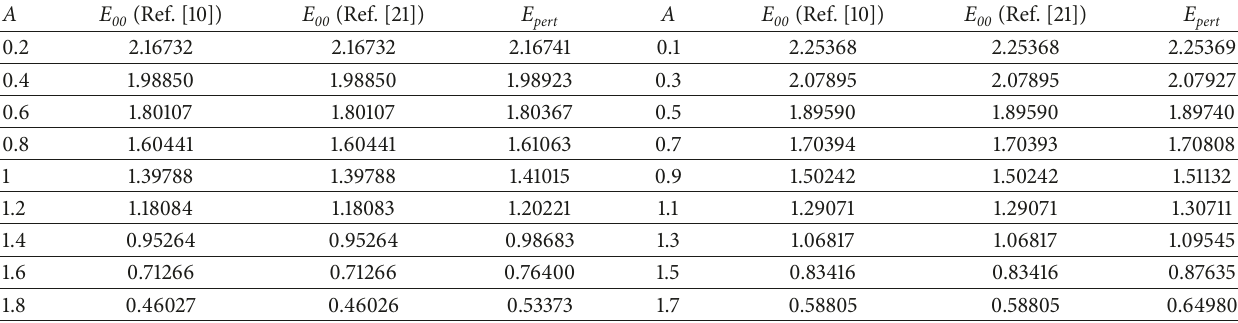
Table 5: Comparisons of energy eigenvalues (in GeV) obtained by using the perturbation expansion formula in (26) ( 𝐸 𝑝𝑒𝑟𝑡 ) with the ones of s-wave heavy quarkonium from [10, 21]. The potential parameter 𝐵 is taken as 𝐵 = 1 GeV, while the reduced mass is 𝜇 = 1/2 GeV in this case. The eigenvalues of [10, 21] are exact